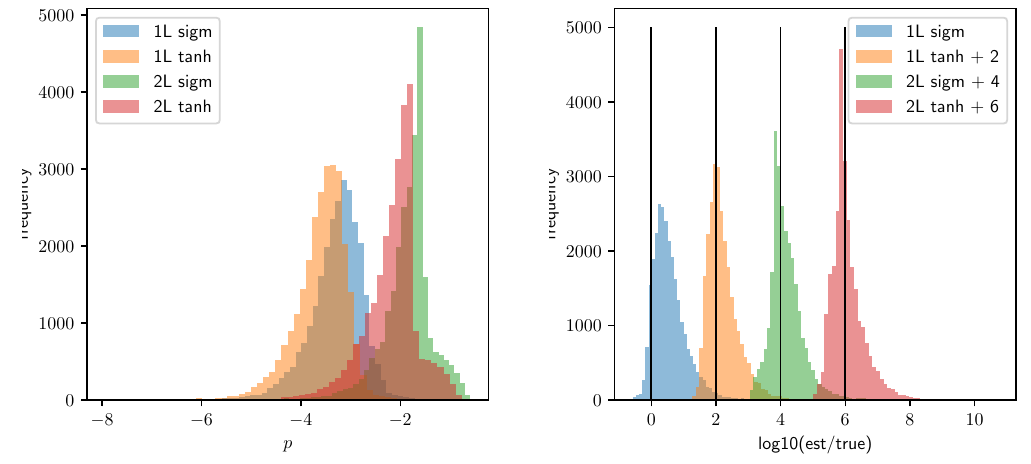
Figure 3 . Left: number of digit accuracy for the two integrals for two different activation functions. Right: ratio of the actual error of the standard deviation of the replica results. The histograms are shifted for readability. The vertical lines correspond to the actual error matching the standard deviation of the network